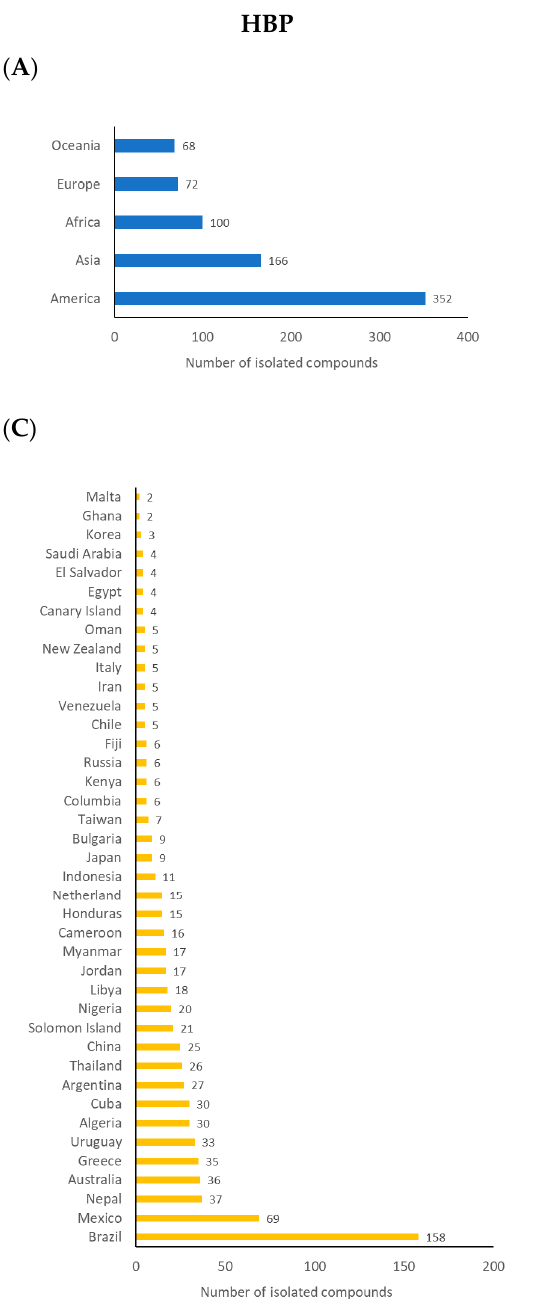
Figure 5. Geographic distribution of compounds isolated from HBP ( A , C ) and SBP ( B , D ) based on continents ( A , B ) and countries ( C , D ).